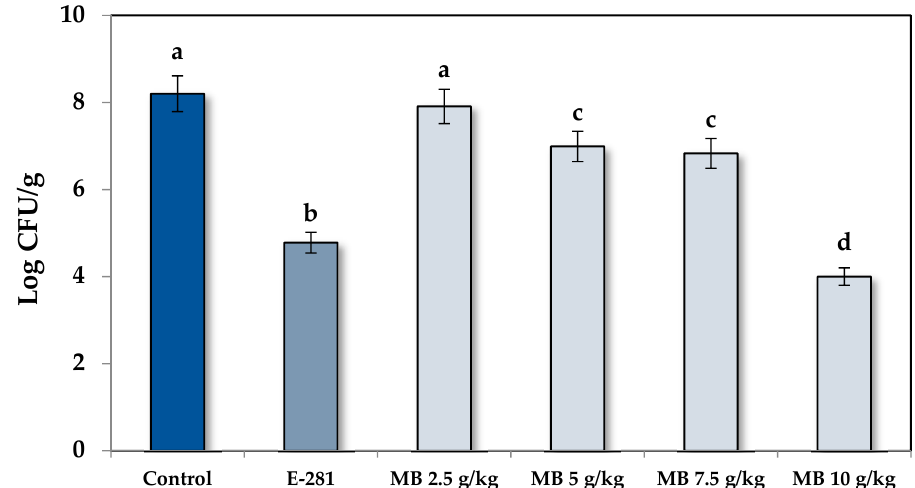
Figure 2. The fungal population of the loaf bread formulated with MB (2.5, 5, 7.5, and 10 g/kg) and contaminated with P. commune CECT 20767. The control group did not receive any treatment, and the commercial treatment was performed with sodium propionate (E-281) at 2 g/kg. Different letters mean significant differences between treatments ( p < 0.05).